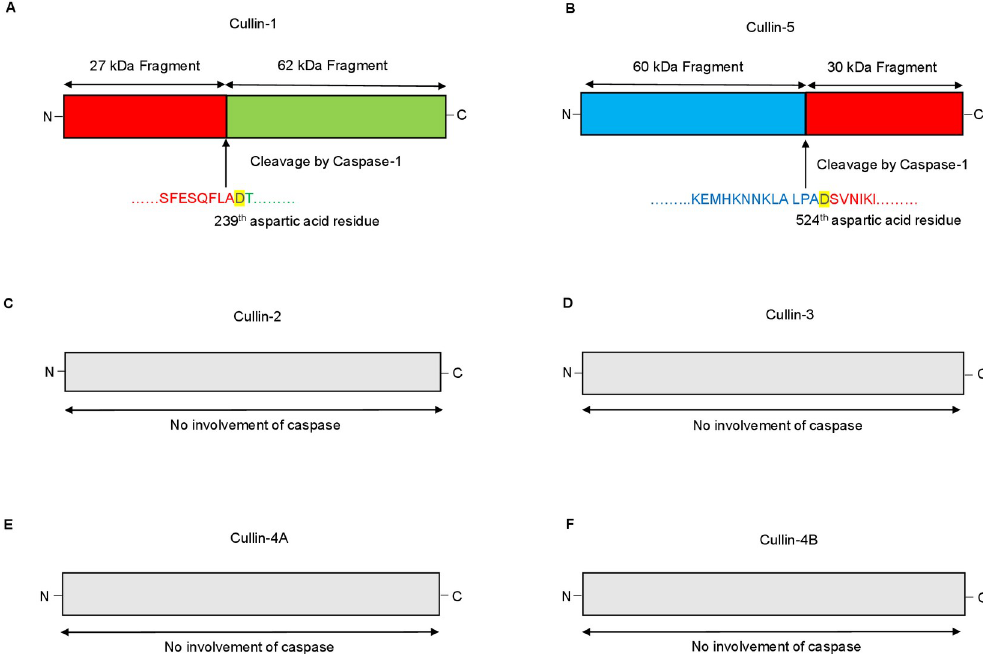
Fig 4. Potential cleavage site prediction by caspases in different cullin using the software peptide cutter. The software Peptide Cutter (ExPASy) that predicts potential cleavage sites by different chemicals and proteases against a given query (Protein sequence) was used, for determining the potential cleavage site in different cullin protein’s (cullin-1, cullin-2, cullin- 3, cullin-4A, cullin-4B and cullin-5). (A) The yellow color at D 239 , aspartic acid residue (arrow) represents the potential site for cullin-1 cleavage by caspase-1. The sequence in red represents a fragment of 27 kDa and the sequence in green represents a fragment of 62 KDa. ( B) The yellow color at D 524 , aspartic acid residue (arrow) denotes the potential cleavage site for cullin-5 by caspase-1. The sequence in blue represents a fragment of 60 kDa, while the sequence marked in red represents a 30 kDa fragment. (C-F) No potential cleavage sites for caspase-1 were noted for cullin-2, 3, 4A and 4B.